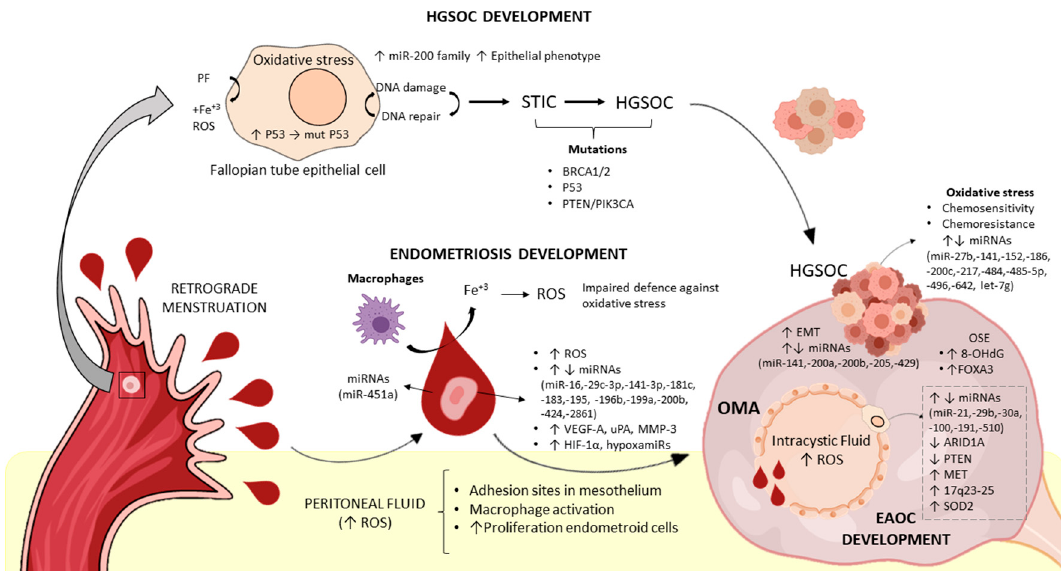
Figure 3. Global vision of aetiopathogenic mechanisms leading to endometriosis, EAOC and HGSOC development. Regarding HGSOC development, oxidative stress contributes to fallopian tube epithelial cells alterations, through the action of ROS. Repeated cycles of DNA damage and repair produce mutations in driver genes BRCA1/2 , P53 , PTEN and PIK3CA . Additionally, miRNA deregulation contributes to tumour progression. Once the malignant lesion is established in the ovary, oxidative stress is initially involved in first-line chemotherapy mechanism of action, although excessive oxidative stress is linked to tumour chemoresistance. Regarding endometriosis development, refluxed endometrial cells from patients show some features predisposing them to the development of this condition (i.e., increased angiogenesis and proteolysis, disbalanced miRNAs profile, etc). Upon menstruation, endometrial cells lose their blood supply and activate hypoxia-responsive miRNAs (hypoxamiRs) that together with erythrocyte-derived miRNAs contribute to the development of the condition. Blood decomposition by pelvic macrophages contribute to ROS production, which alters the peritoneal microenvironment to enhance endometrial cells attachment and proliferation. Finally, the intra-cystic fluid of OMAs presents with higher levels of ROS, triggering subsequent events such as miRNAs disbalance, decreased expression of ARID1A and PTEN, amplification of MET and 17q24–25, and increased generation of SOD2, all of which enhance the development of EAOC. Abbreviations: EAOC, endometriosis-associated ovarian cancer; HGSOC, High-Grade Serous Ovarian Cancer; STIC, Serous Tubal Intraepithelial Carcinoma; OSE, Ovarian Surface Epithelium; OMA, Ovarian endometrioma; ROS, Reactive Oxygen Species; PF, Peritoneal Fluid; BRCA, Breast Cancer gene; PTEN, Phosphatase and tensin homolog; PIK3CA, Phosphatidylinostil-4,5 Biphosphonate 3-Kinase Catalytic Subunit Alpha; VEGF-A, Vascular Endothelial Growth Factor A; uPA, Urokinase-type plasminogen Activator; MMP-3; Matrix Metallopeptidase 3; HIF-1 α ; Hypoxia-inducible factor 1-alpha; ARID1A, AT-Rich Interaction Domain A; MET, mesenchymal-to-epithelial transcription factor; EMT, Epithelial-Mesenchymal Transition; SOD2, Superoxide Dismutase 2; FOXA3, Hepatocyte Nuclear Factor 3-gamma; 8-OHdG, 8-Oxo-2 ′ - deoxyguanosine.